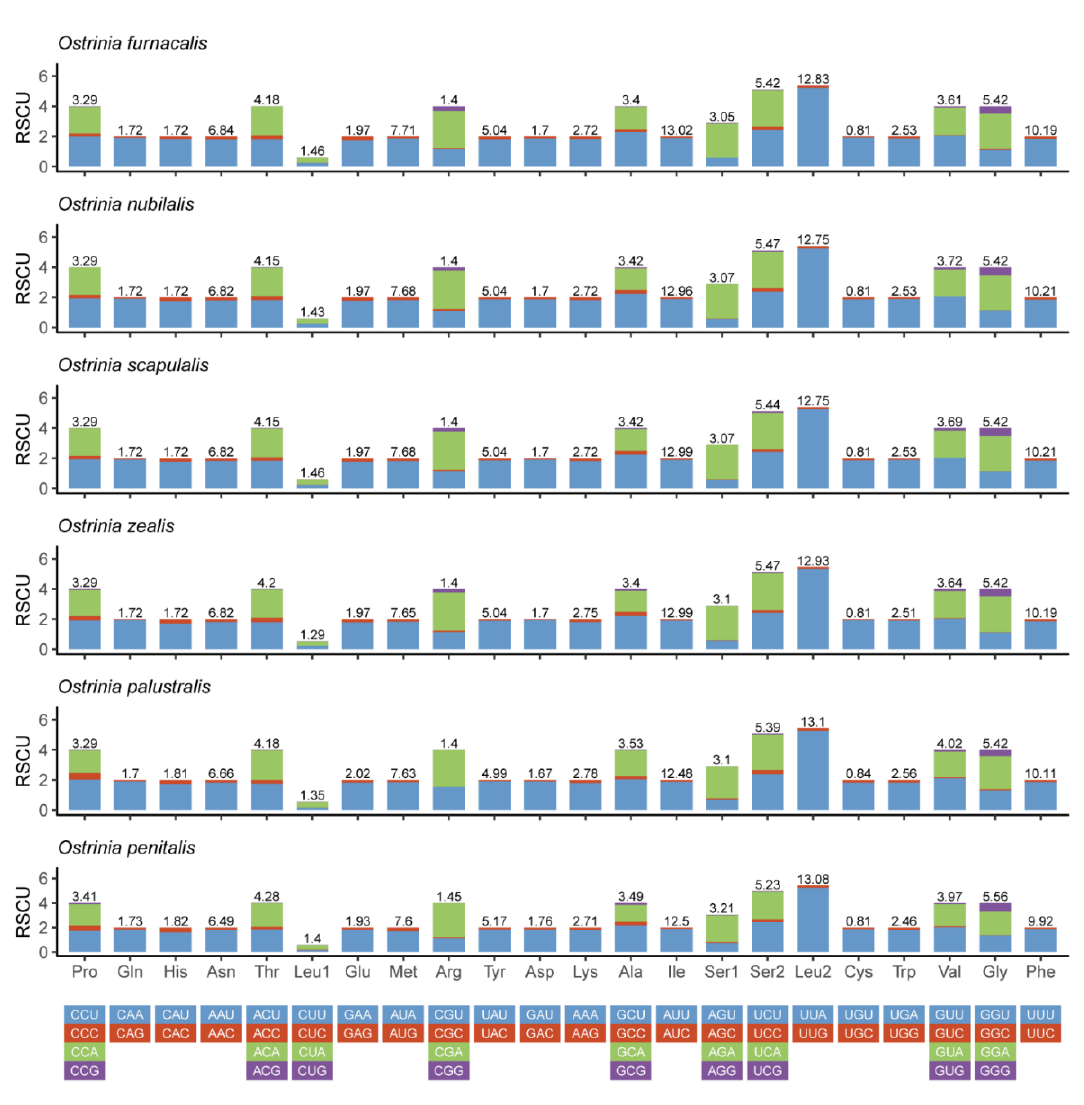
Figure 2. Relative synonymous codon usage (RSCU) in the mitogenomes of Ostrinia spp.